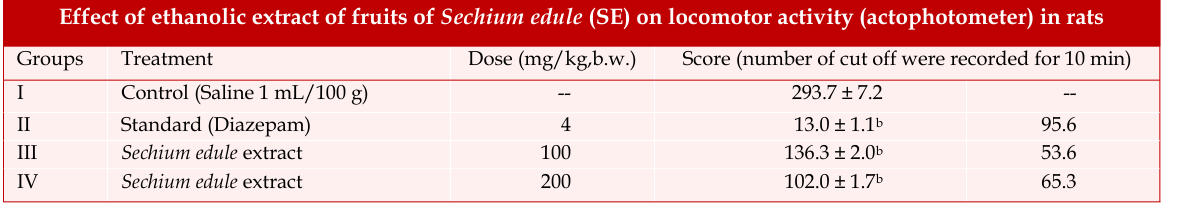
Effect of ethanolic extract of fruits of Sechium edule (SE) on locomotor activity (actophotometer) in rats Groups